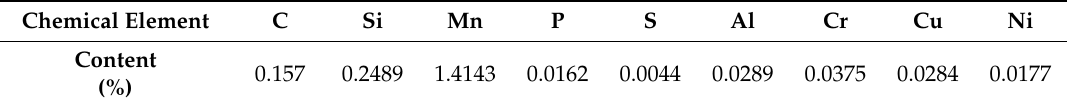
Table 2. Chemical composition and content of AH36.